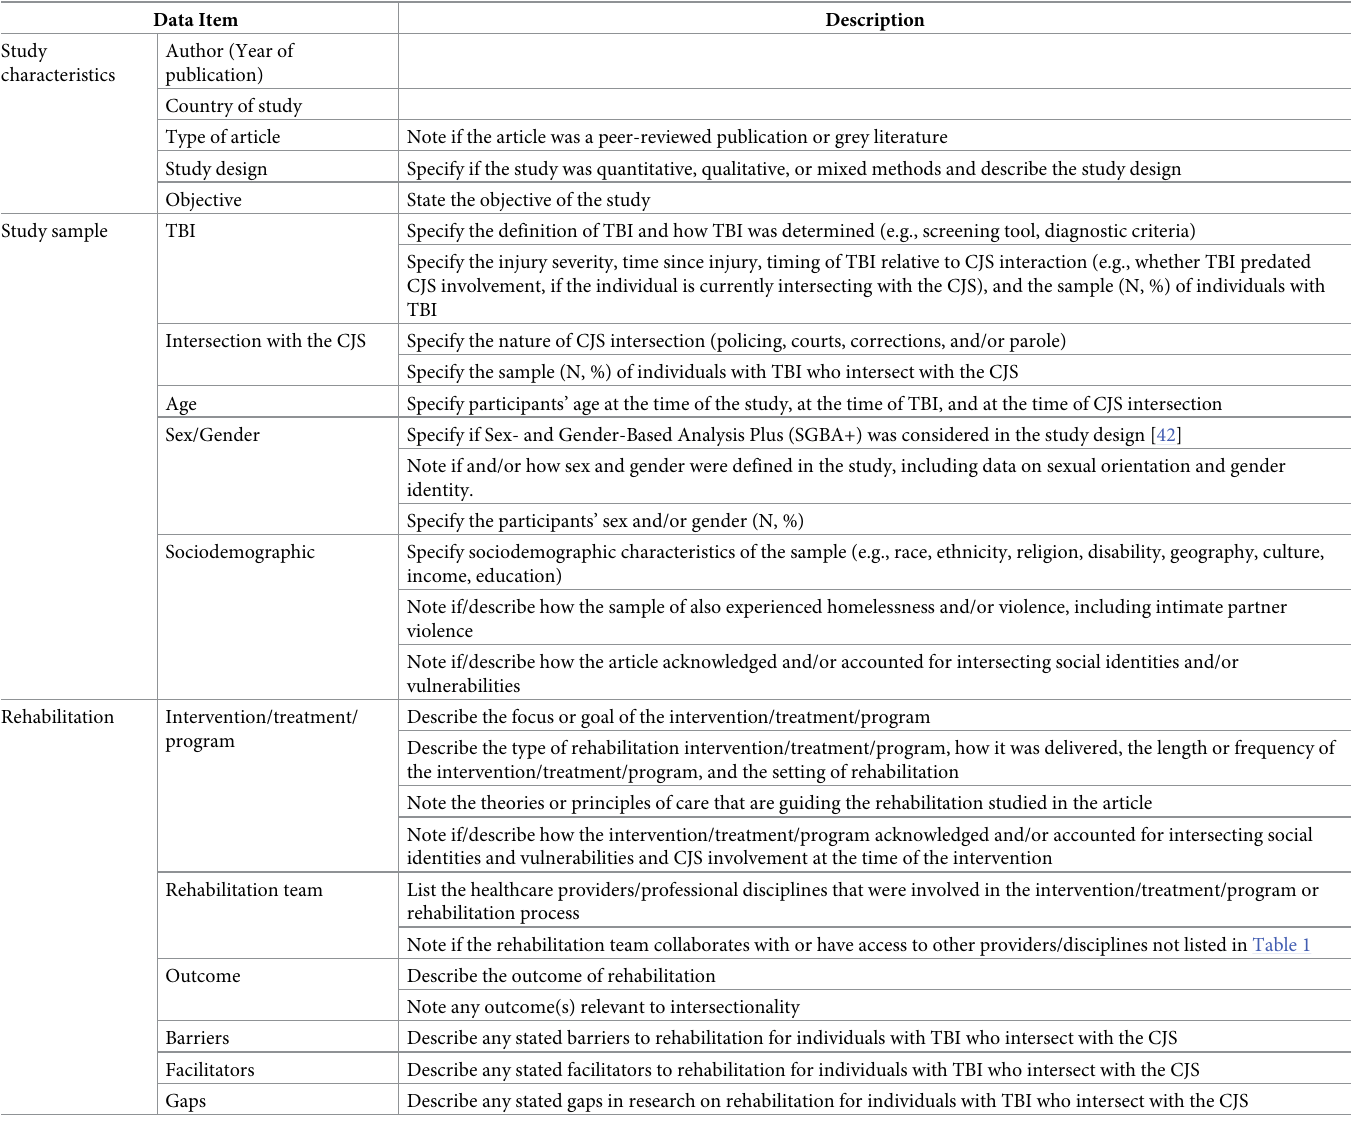
Table 2. Charting